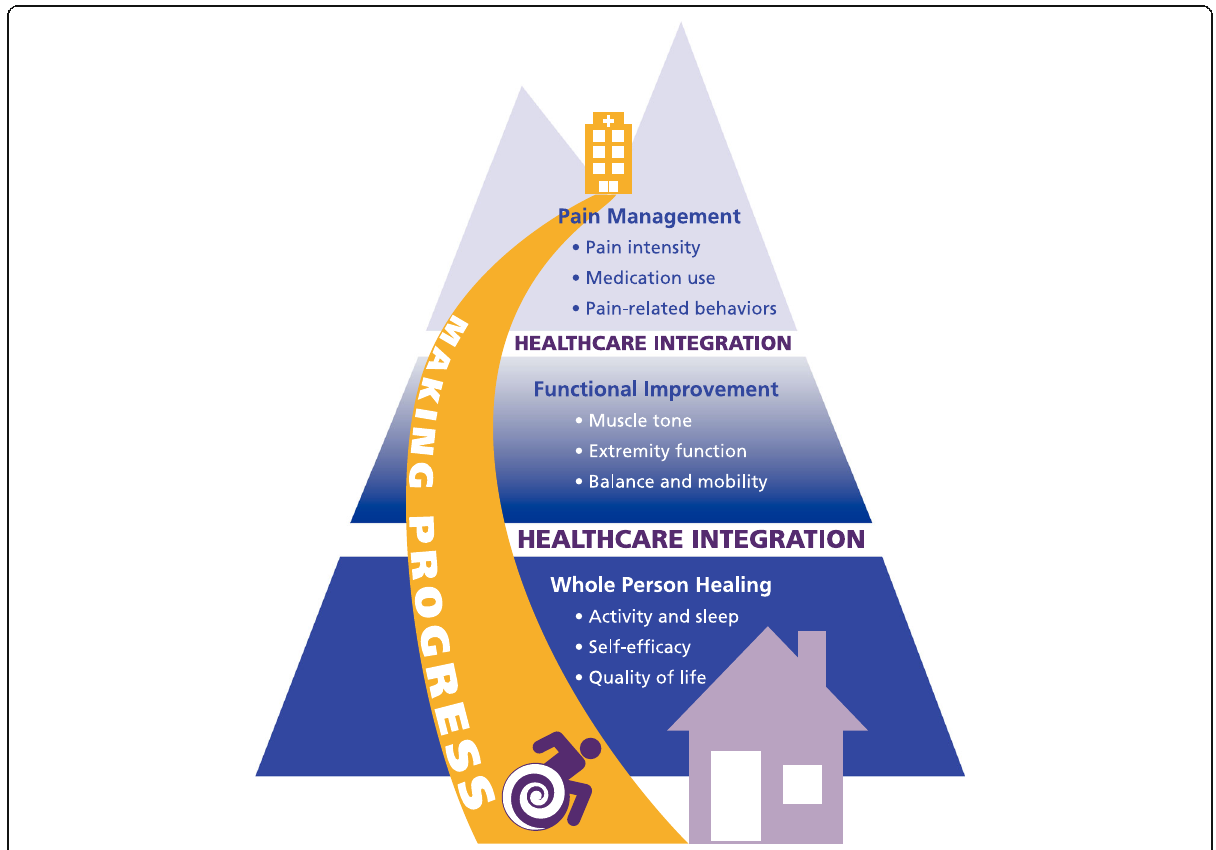
Fig. 1 Stakeholder expectations from the integration of chiropractic care into a rehabilitation